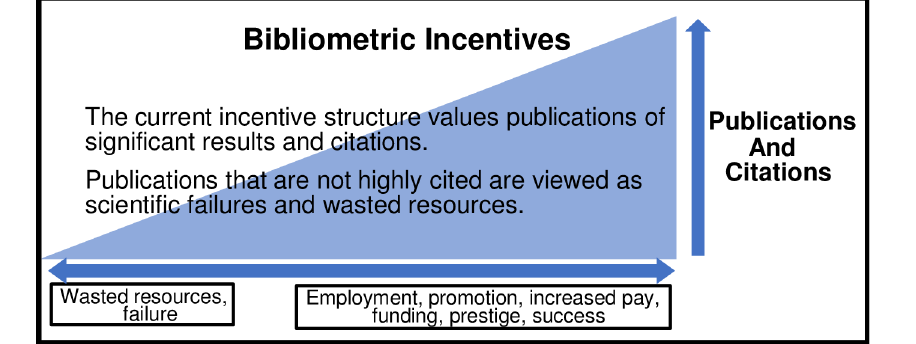
Fig 1. The current bibliometrics incentives